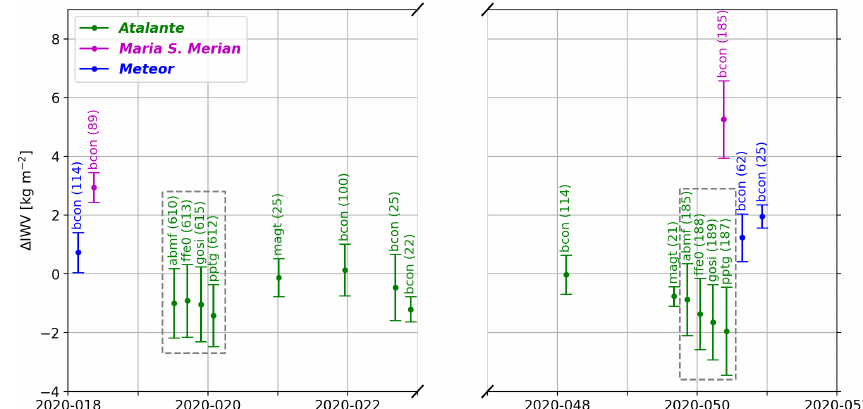
Figure 9. Comparisons of GNSS IWV from the three R/Vs to GNSS IWV retrieved from ground-based GNSS stations when the R/Vs pass close to the stations. The dots represent the mean difference (ground-based stations − R/V), and the error bars represent the standard deviation of differences. The x axis represents time. The central period is not displayed because no data could be compared as the ships were far offshore. Results enclosed in the two dashed-line rectangles are valid at the same time but are separated in the plot for legibility. The three ships are distinguished by different